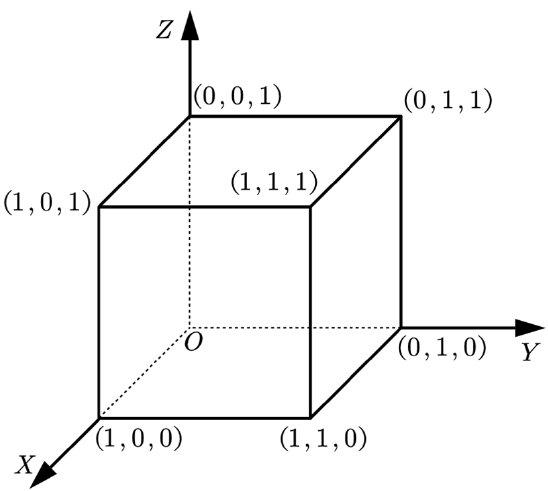
Figure 3. Three-dimensional individual space.